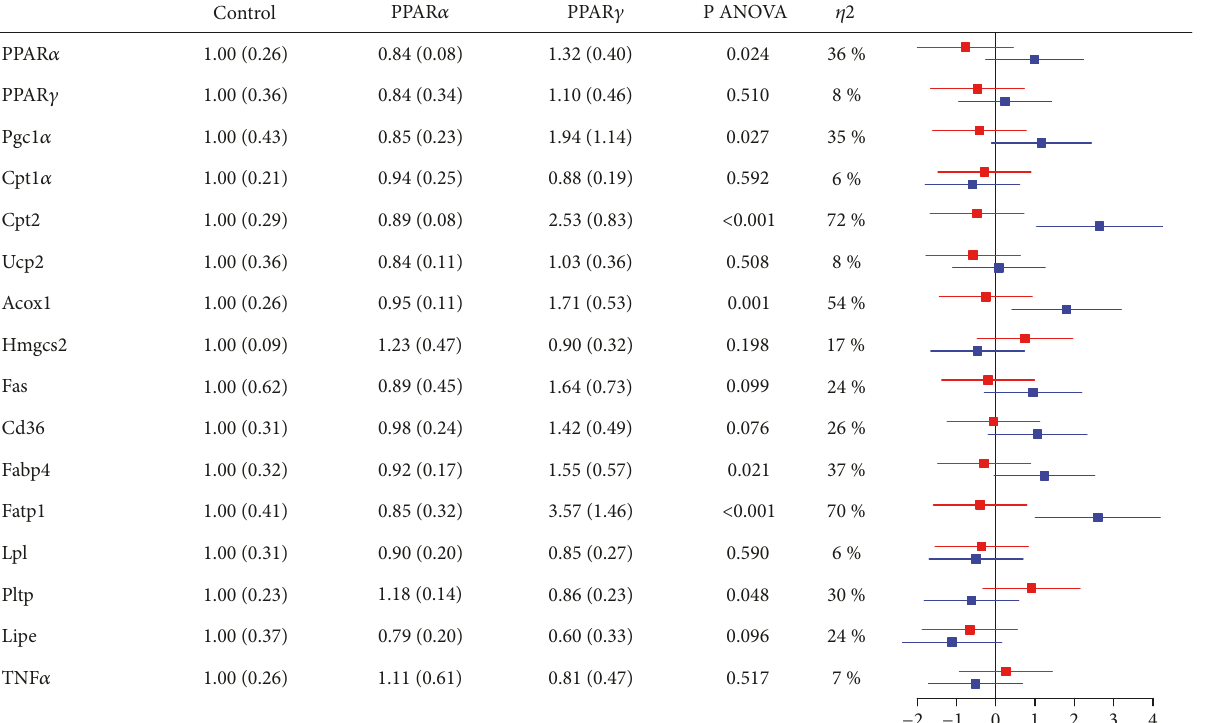
Figure 5: Epididymal adipose tissue gene expression in Wistar rats after treatment with PPAR agonists for 12 days, normalized towards the control group. Red bars correspond to PPAR 𝛼 vs control and blue bars to PPAR 𝛾 vs control. Acox1, fatty acyl-CoA oxidase 1; ANOVA, analysis of variance; Cd36, cluster of differentiation 36; Cpt1a, carnitine palmitoyltransferase 1a; Cpt2, carnitine palmitoyltransferase 2; Fabp4, fatty acid binding protein 4; Fas, fatty acid synthase; Fatp1, fatty acid transport protein 1; Hmgcs2, 3-hydroxy-3-methylglutaryl-CoA synthase 2; Lipe, hormone sensitive lipase E; Lpl, lipoprotein lipase; Pgc1 𝛼 , peroxisome proliferator-activated receptor › coactivator 1 𝛼 ; Pltp, phospholipid transfer protein; Ppar 𝛼 , peroxisome proliferator-activated receptor 𝛼 ; Ppar › , peroxisome proliferator-activated receptor › ; TNFa, tumor necrosis factor alpha; Ucp2, Uncoupling protein 2.